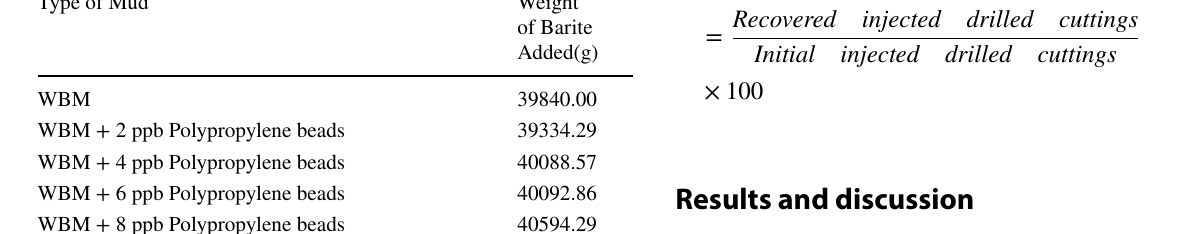
Table 2 Weight of barite needed for different polypropylene concen- trations Type of Mud